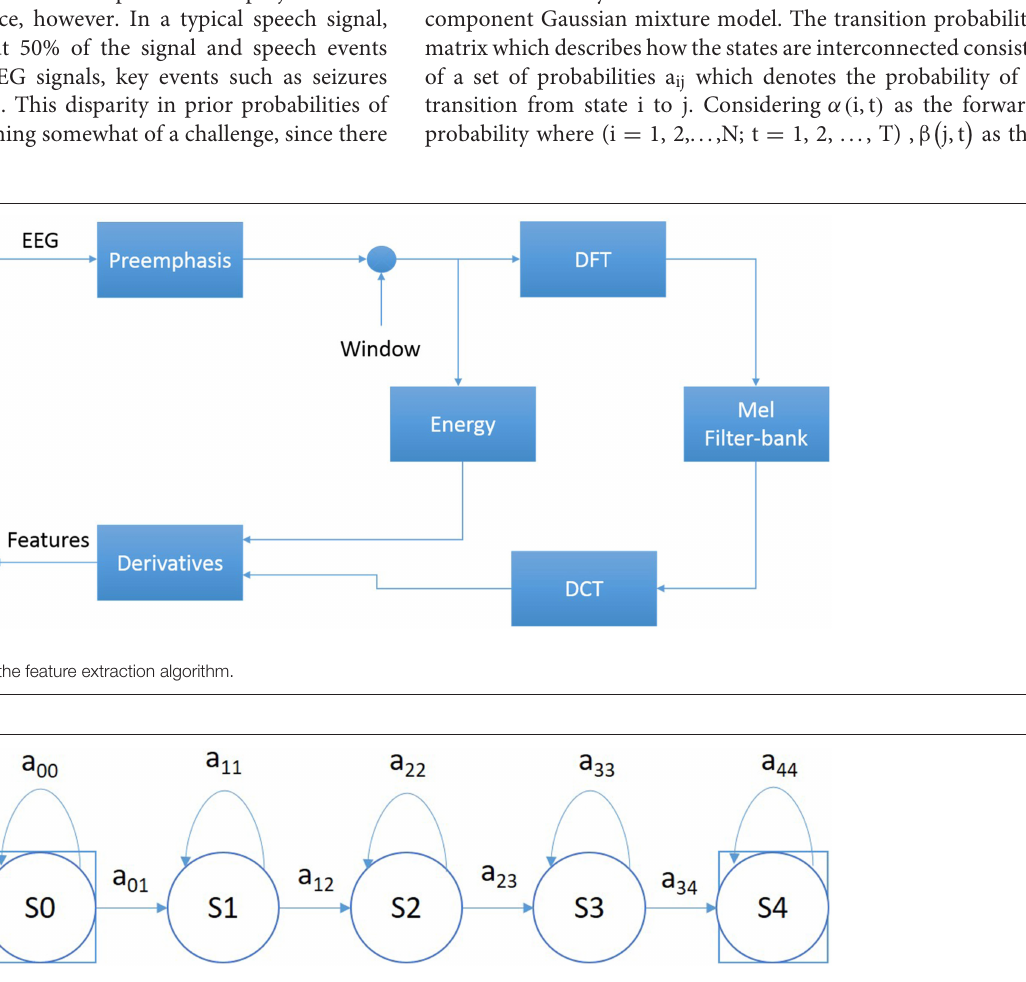
FIGURE 5 | A left-to-right HMM is used for sequential decoding in the first pass of processing.